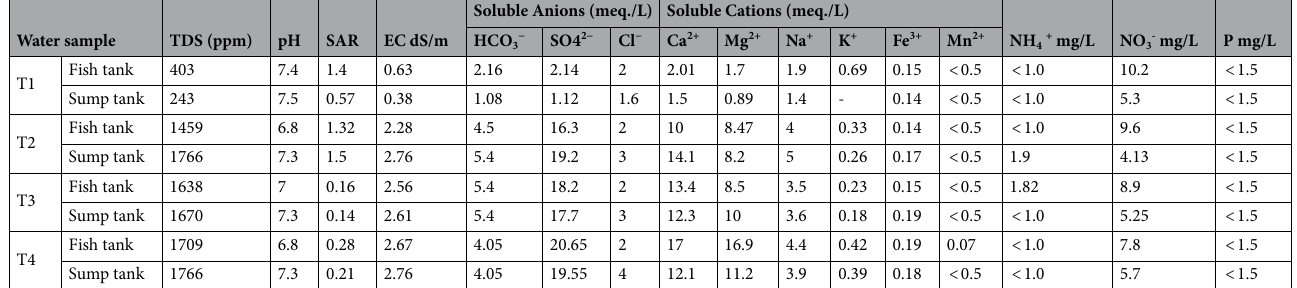
Table 4. Water sample analysis for the different systems’ fish tanks and sump tanks. TDS total dissolved solids, SAR Sodium adsorption ratio, EC electrical conductivity, HCO 3 − hydrogen carbonate ions, SO 4 2− sulfate ions, Cl − chloride ions, Ca 2+ calcium ions, Mg 2+ magnesium ions, Na + sodium ions, K + potassium ions, Fe 2+ ferric, Mn 2+ manganese ions, NH 4 + ammonium ions, NO 3 − nitrate, P